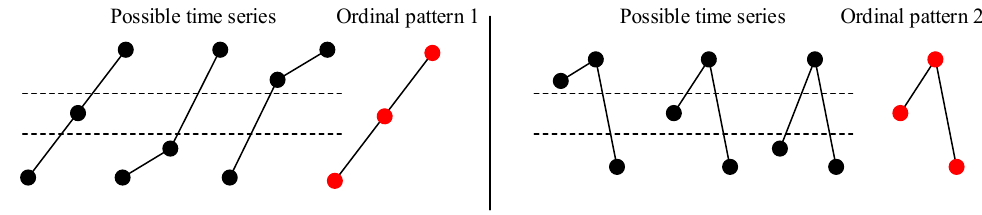
Figure 1. Two examples of possible time series corresponding to the same ordinal pattern.